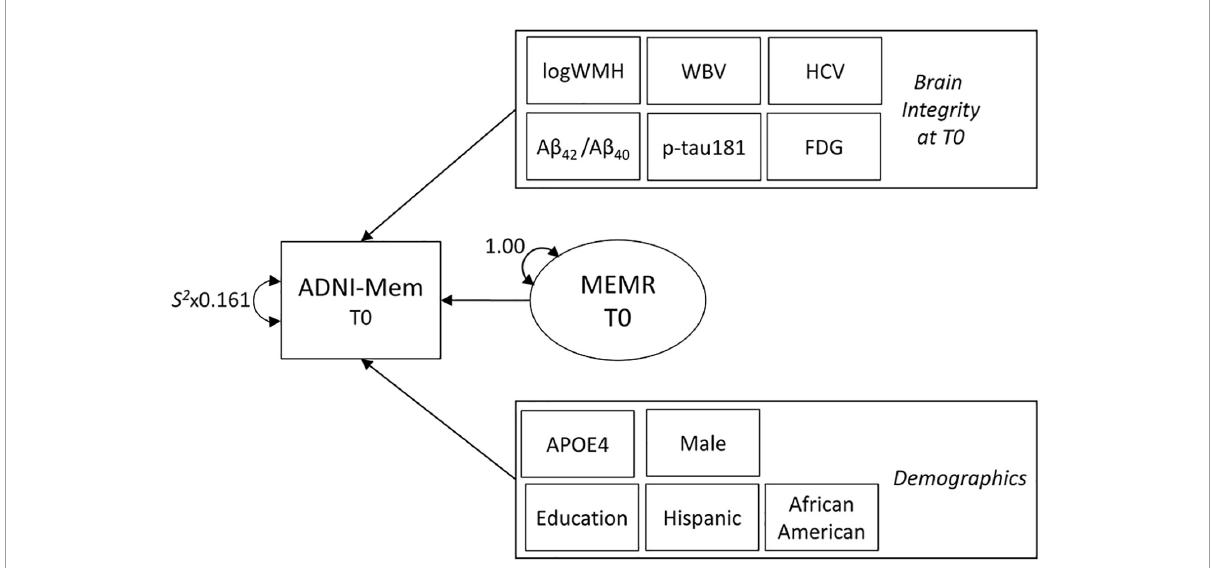
FIGURE2 The decomposition model used to define the residual reserve index. Variance in baseline (T0) episodic memory performance (ADNI-Mem) is decomposed into variance explained by indicators of brain integrity (also measured at T0), demographic indicators, and the residual reserve index (MEMR). Rectangles represent observed variables and ovals represent latent variables. Observed brain integrity and demographic variables are contained within single rectangles to simplify the diagram. Parameters are freely estimated unless labeled otherwise. Double-ended arrows represent variance or residual variance. S 2 = sample variance (multiplied by measurement error). Not shown: whole brain (WBV) and bilateral hippocampal (HCV) volumes were regressed onto total intracranial volume to correct for head size. Correlations between observed variables were initially freely estimated, then non-significant correlations were constrained to zero to facilitate model convergence. Correlations between MEMR and observed variables were constrained to zero. ADNI-Mem, ADNI’s composite of episodic memory performance; logWMH, log-transformed white matter hyperintensity volume; A β 42 /A β 40 , ratio of CSF β -amyloid 1 - 42 to β -amyloid 1 - 40 ; p-tau181, plasma phosphorylated tau 181; FDG, uptake of 18 F fluorodeoxyglucose tracer in AD-specific regions of interest; APOE4, number of apolipoprotein-E ε 4